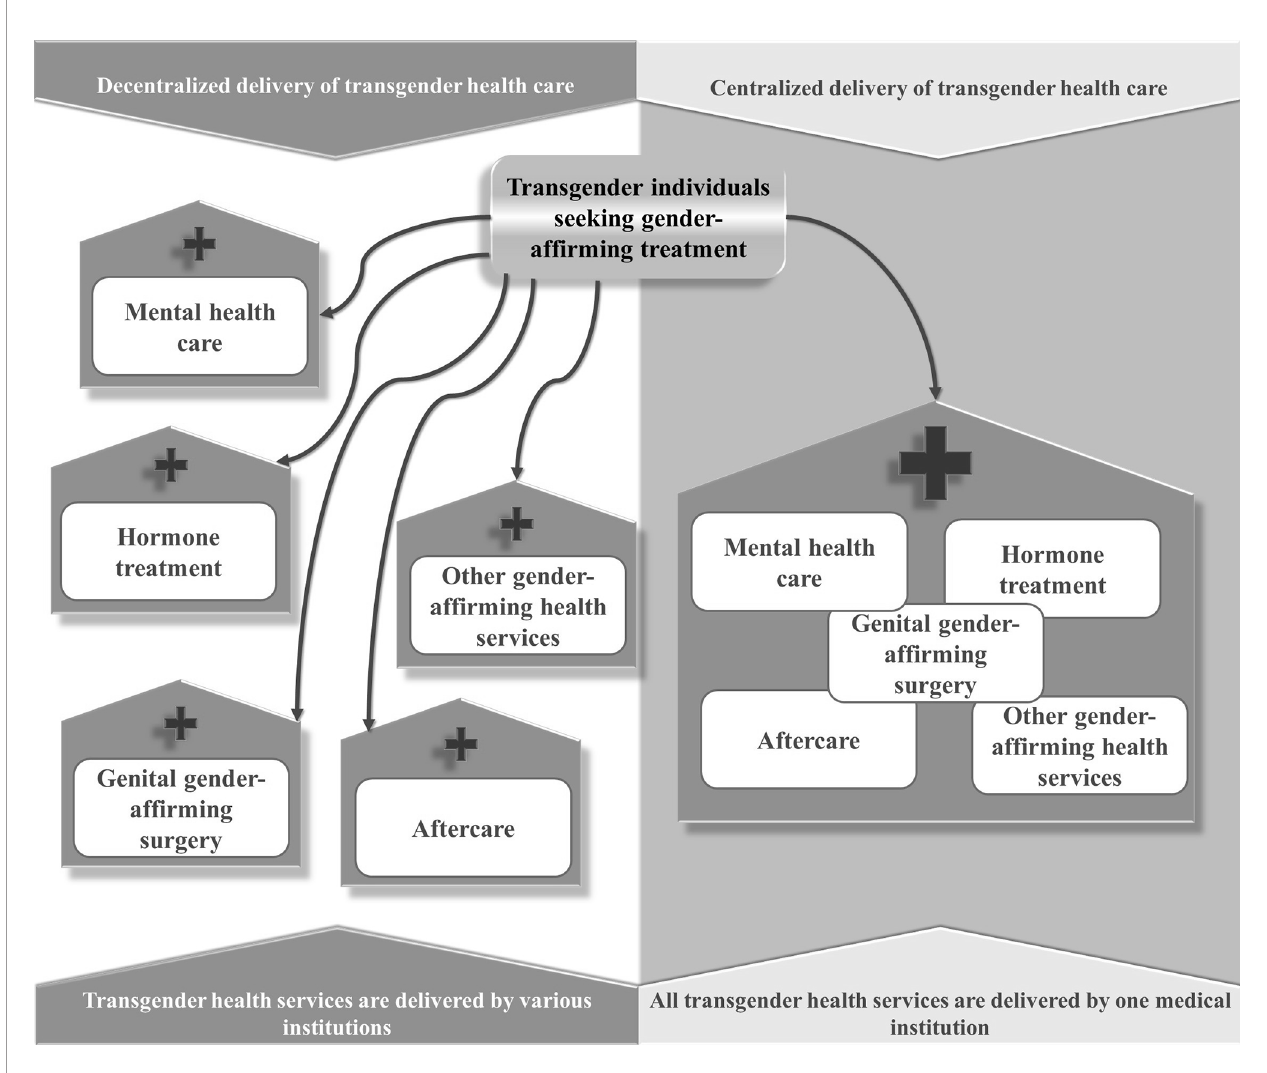
FIGURE 1 | Centralized and decentralized delivery of transgender health